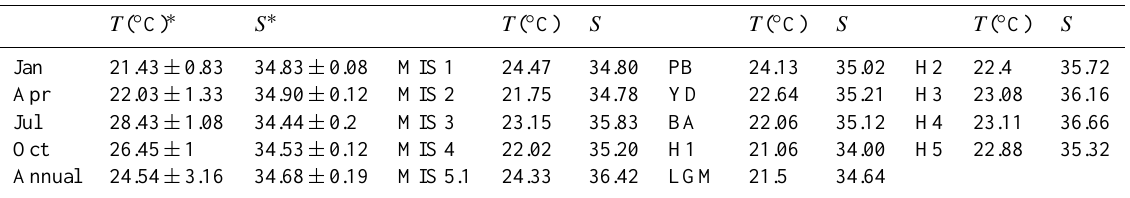
Table 3. Average SST and SSS from proxies of different periods for core CSH1 and from instrumental records in the study area around 28–29 ◦ N, 131–132 ◦